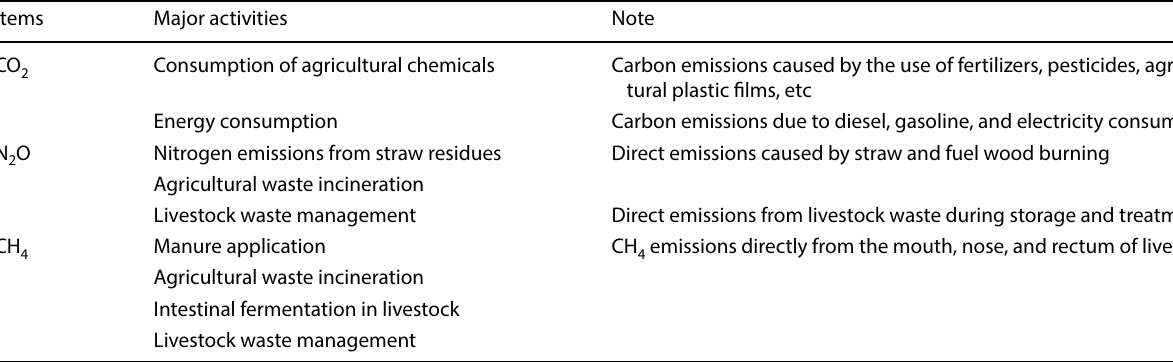
Table 1 Emission factors of agricultural